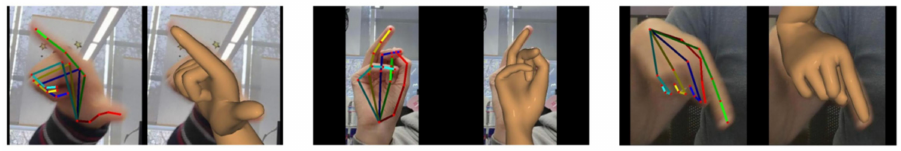
Figure 13. A sample extracted from the